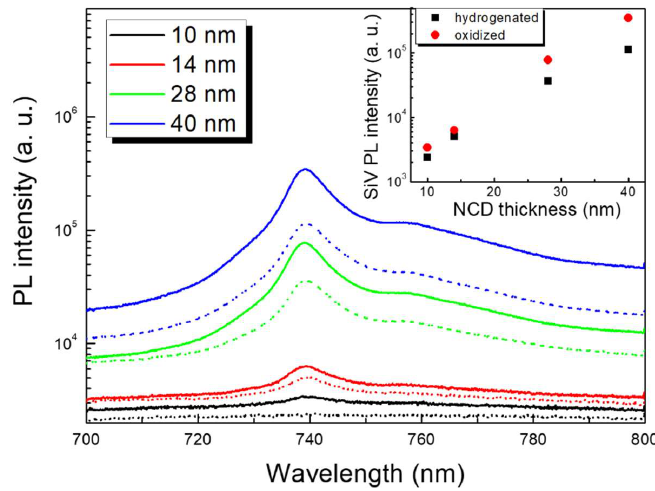
Figure 2. Semi-log plots of photoluminescence (PL) spectra showing shallow silicon vacancy (SiV) PL evolution of plasma-hydrogenated H1-NCD1 films (dotted lines) and air-annealed, i.e., oxidized, O2-NCD1 films (full lines) in dependence on increasing NCD film thickness. The inset shows SiV PL intensity in semi-log scale as a function of NCD film thickness and the NCD surface chemistry.